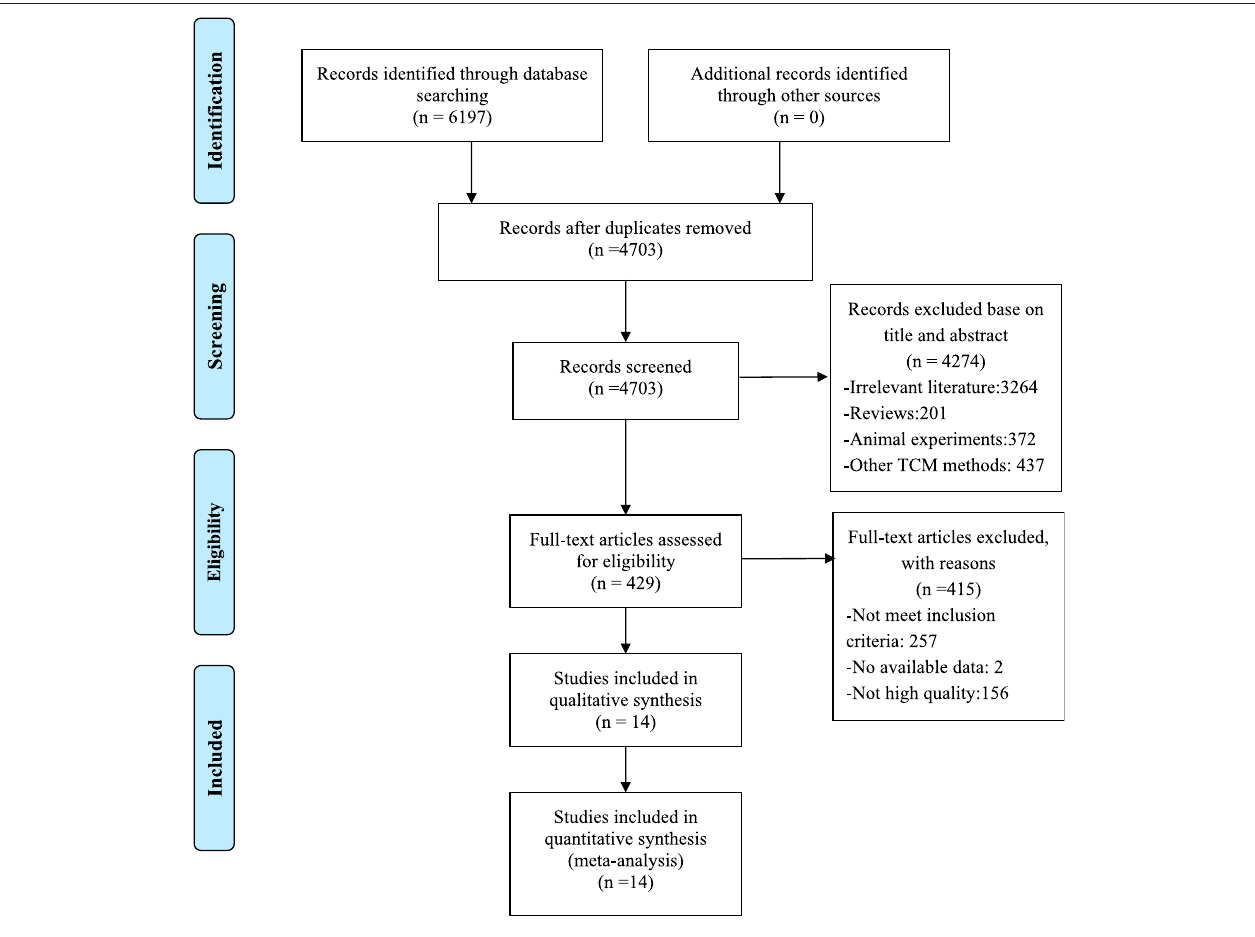
FIGURE 1 | Flowchart of screening